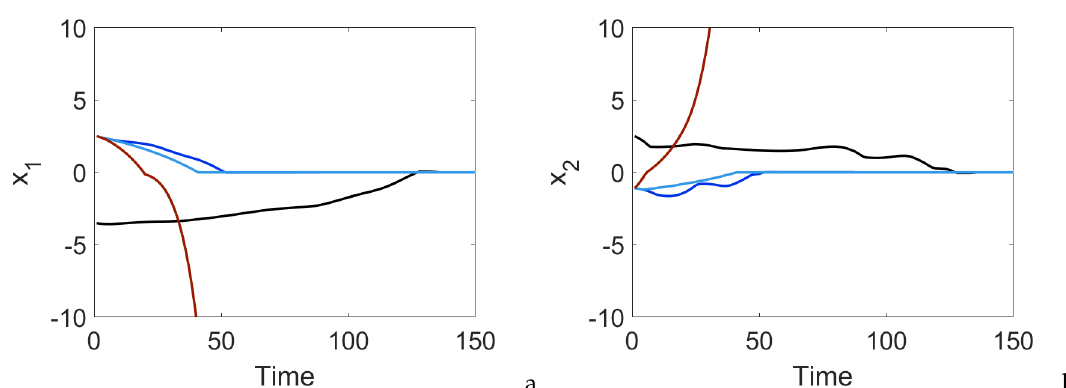
(cid:2) 2.5 (cid:3) (red), V NCR for an initial condition of − 1.1 (cid:2) 0.82 0 (cid:3) (dark blue) and V NCR for an initial condition of 0 0.82